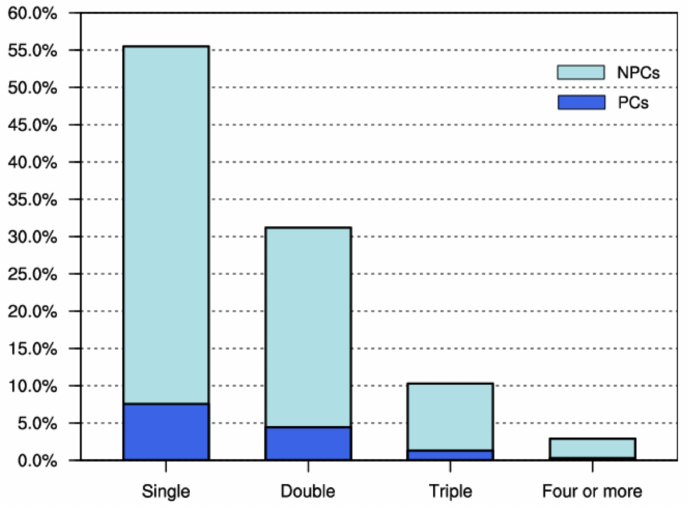
Figure 4. Occurrence frequencies of single- and multi-layer clouds in all cloud samples. The frequen- cies shown in deep blue are the fraction of precipitating clouds in each cloud system. NPCs = non- precipitating clouds; PCs = precipitating clouds.